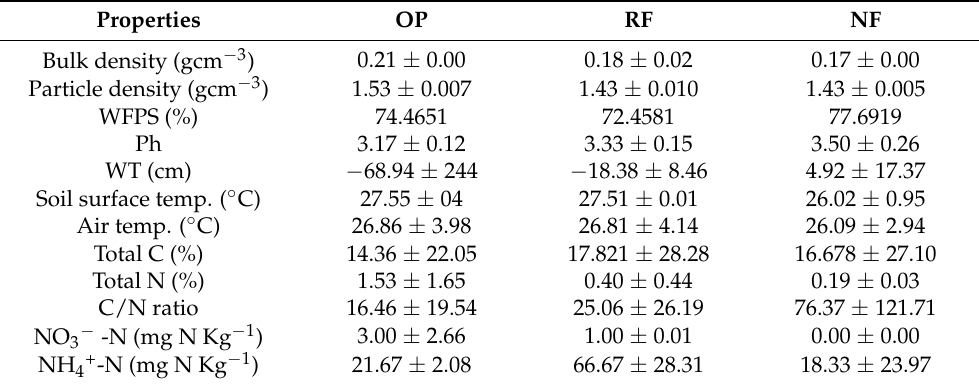
Table 1. Physicochemical properties of peat (mean ± STD) at the drained oil palm plantation (OP), rewetting-restored forest (RF) and undrained natural forest